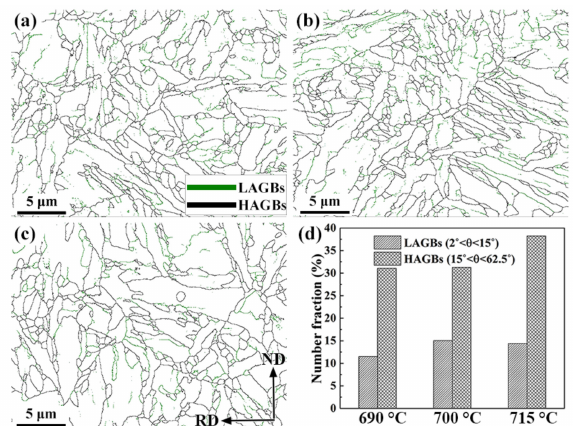
Figure 7. Grain boundary distributions of the 0.5Cr0.4W steels tempered at ( a ) 690 ◦ C, ( b ) 700 ◦ C, ( c ) 715 ◦ C, and ( d ) LAGBs and HAGBs number fraction.